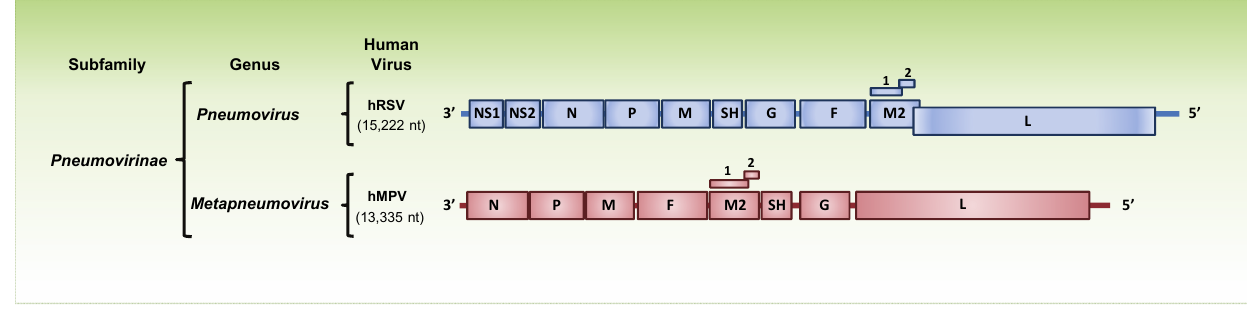
Figure 1. Schematic representation of human Pneumovirus and Metapneumovirus . Gene maps and encoded proteins of members of the subfamily Pneumovirinae: human respiratory syncytial virus (hRSV) and human metapneumovirus (hMPV), which belong to the genera Pneumovirus and Metapneumovirus , respectively. Genes are represented as boxes with the corresponding encoded